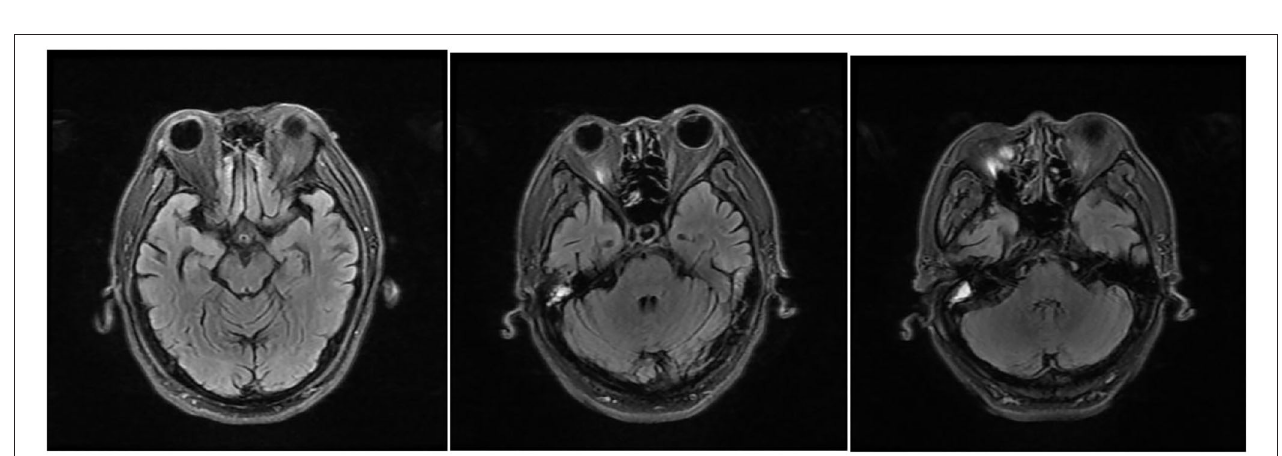
FIGURE 2 | MRI of the patient during his second time in the hospital, T2/fluid-attenuated inversion recovery (FLAIR) showing abnormally high signals around the midbrain aqueduct, around the fourth ventricle, and in the dentate nuclei of the cerebellum bilaterally ( arrows ).